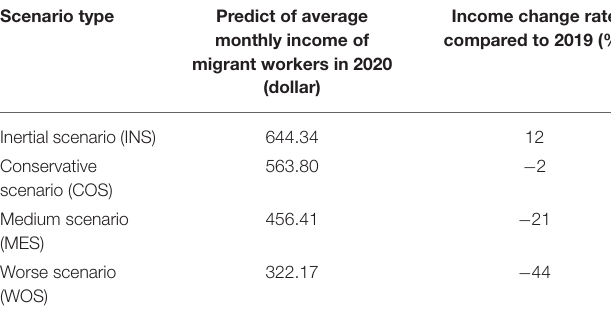
TABLE 5 | Prediction of monthly average income of migrant workers in different